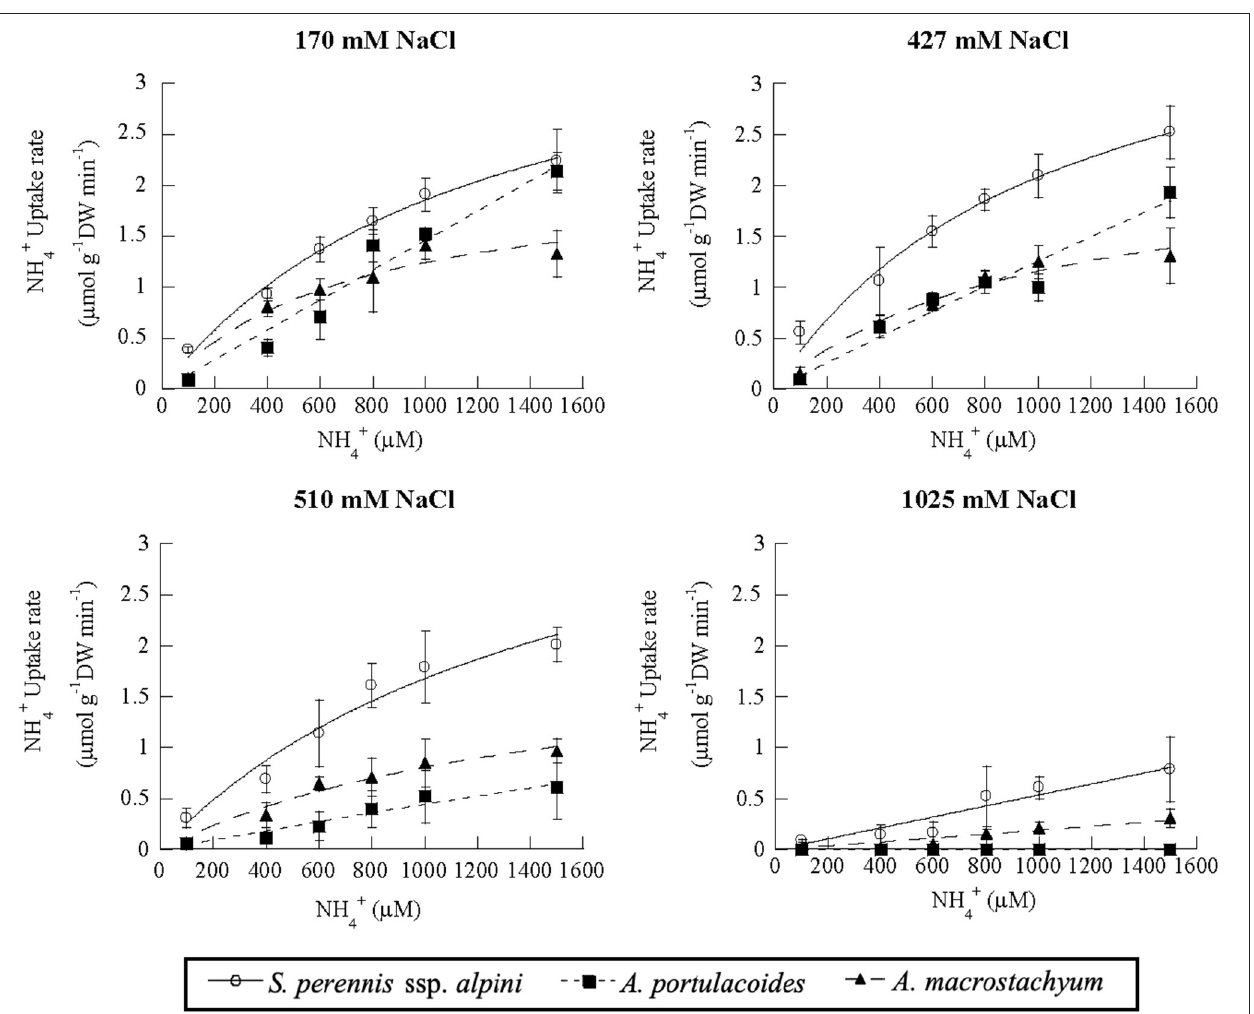
available for the plants (almost two orders of magnitude) and the relatively high energetic cost of reducing and assimilating NO − compared with ammonium (Lambers et al., 1998). The species